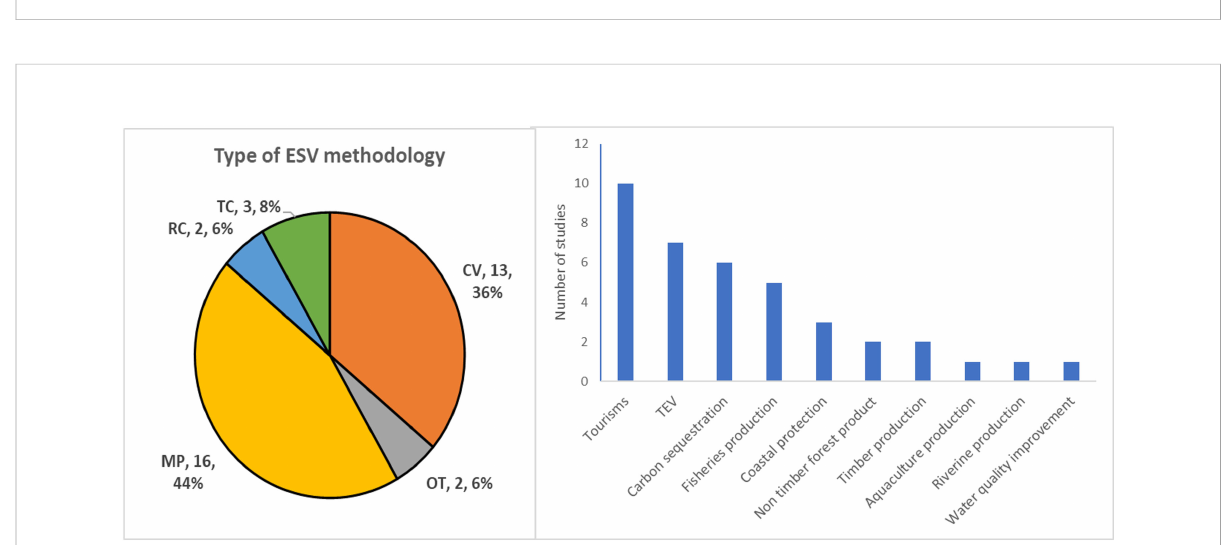
FIGURE 2 Summary of ecosystem service valuation (ESV) methodologies and ecosystem services that had been valued in Malaysia. CV, contingent valuation; MP, market price; BT, bene fi t transfer; RC, replacement cost; TC, travel cost; OT, others including the bene fi t transfer and ecosystem service valuation method (remote